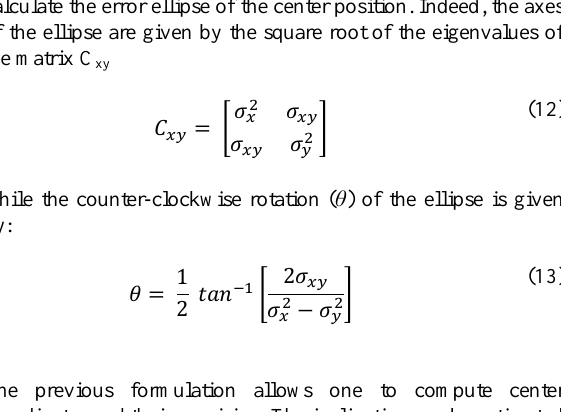
Figure 10. Some images of the schemes used to represent verticality deviations. Original images also have